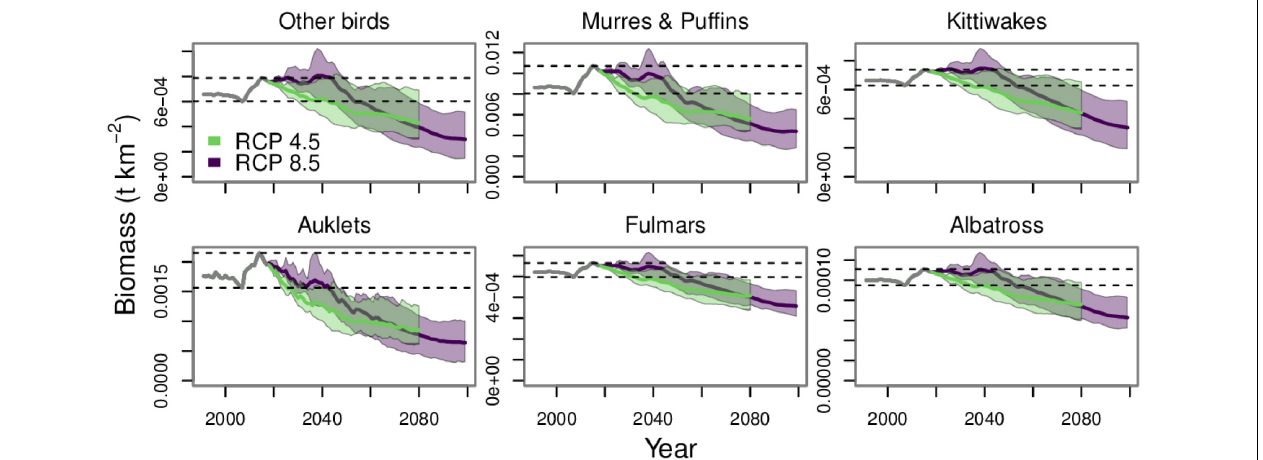
FIGURE 8 | Biomass projections for seabird functional groups. The gray line from 1991 to 2017 indicates the historical period. The purple and green polygons indicate the minimum and maximum range for the three earth system models run under each RCP. The purple and green lines indicate the mean of the three runs for each RCP. The dashed lines indicate the minimum and maximum values from the historical